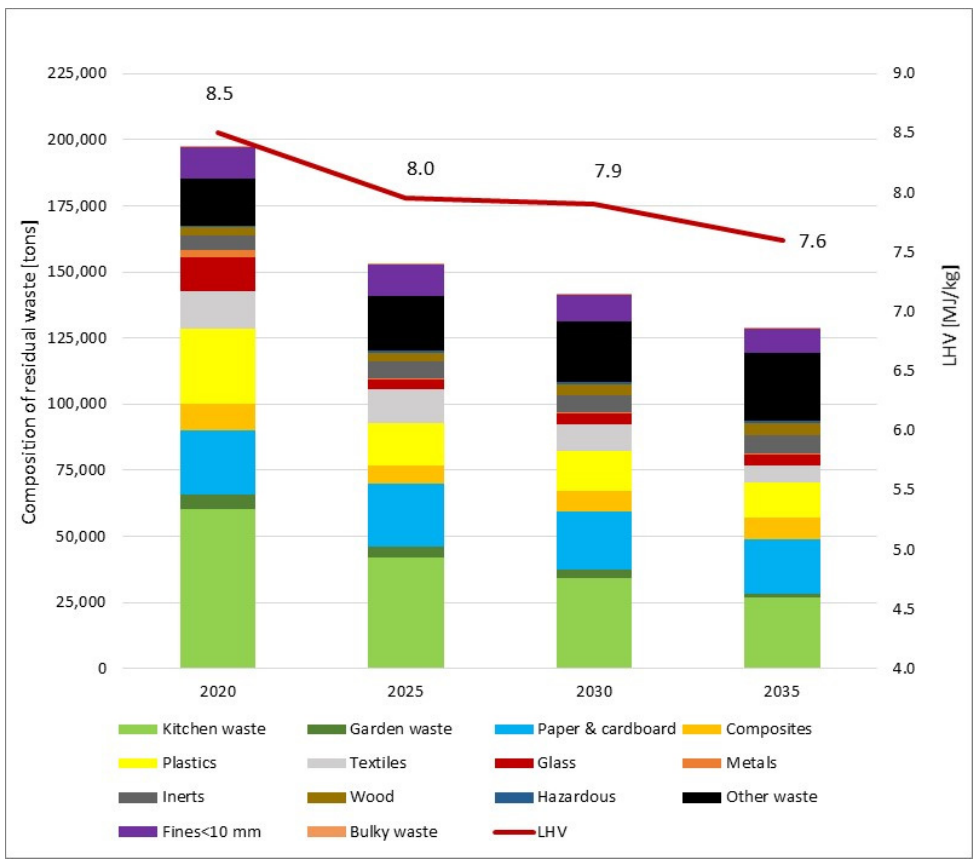
Figure 15. Quantity and fuel properties of residual waste stream in the period 2020–2035.